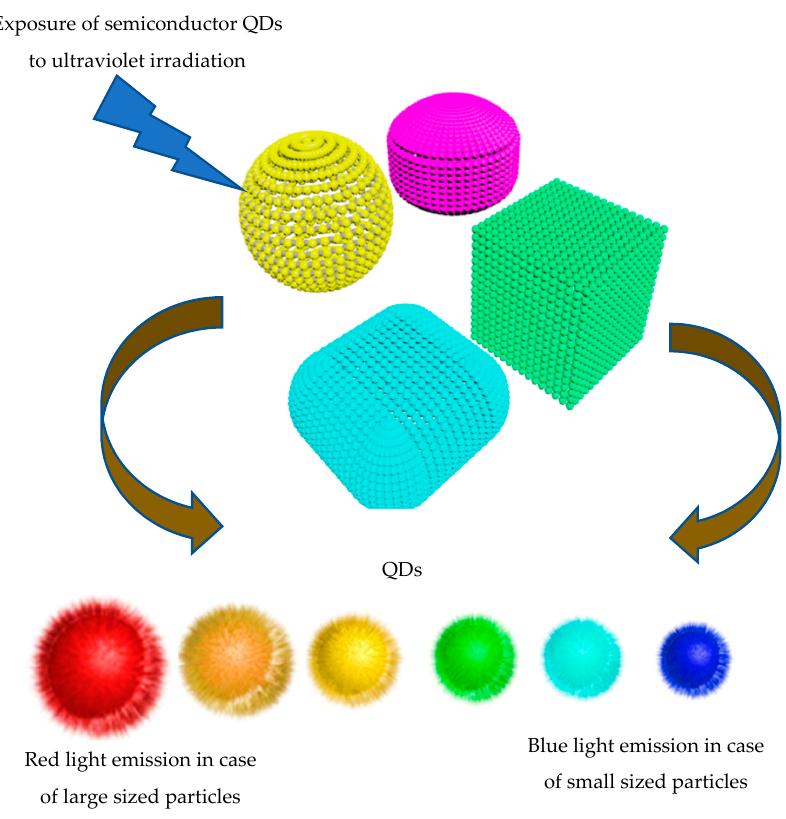
Figure 2. Quantum size confinement effect; irradiation of colloidal quantum dot (QD) particles under a UV light. Emission of different colors is dependent on the shape and size of the prepared particles.